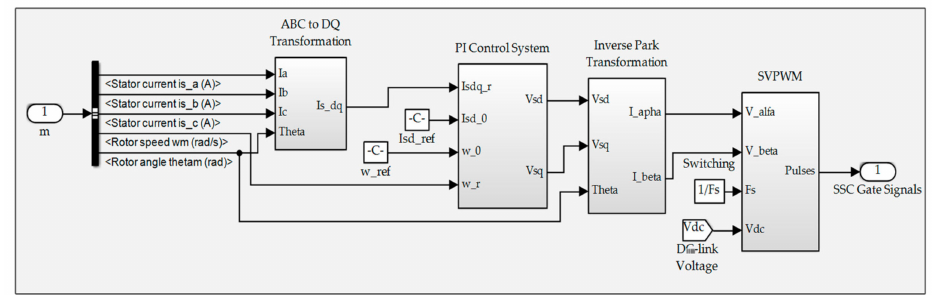
Figure 9. Space vector pulse width modulation (SVPWM)